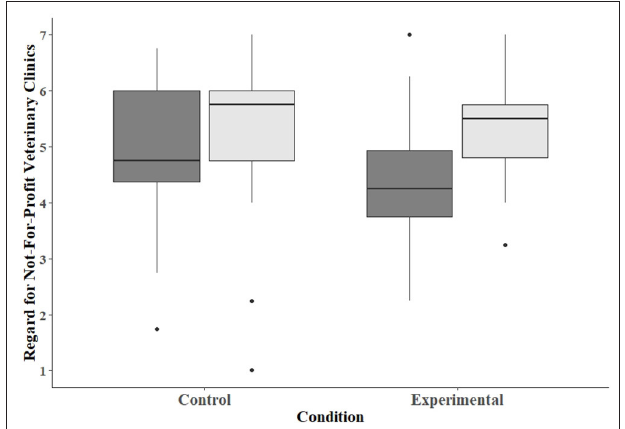
FIGURE 3 | Box plot depicting the scores assessing participants’ confidence in their ability to offer incremental care. Dark-gray bars represent scores on the pretest, and light-gray bars scores on the